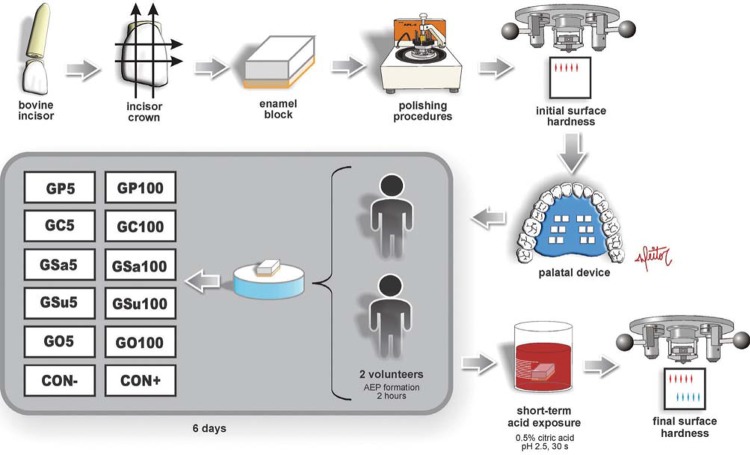
Illustration of the experimental design adopted in this study